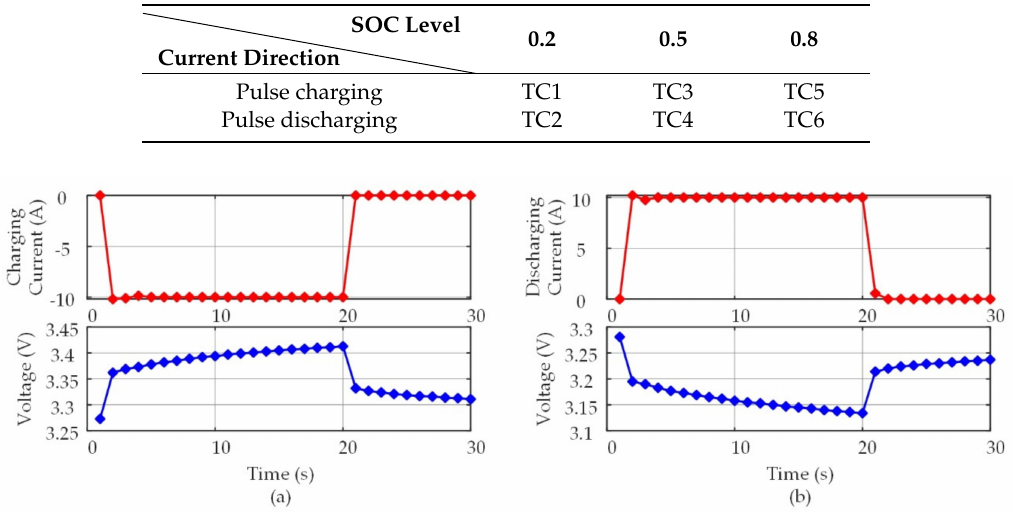
Table 2. Test matrix for obtaining the voltage dataset for training the entropy-based capacity estimator.